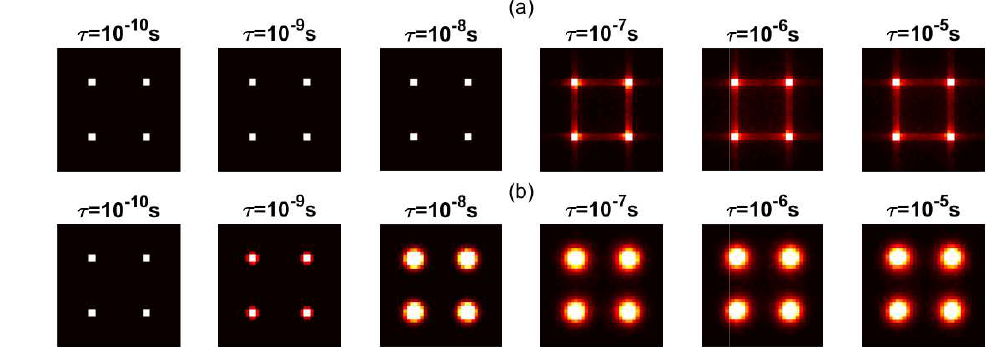
Figure 4. According to the time delay parameter, constellation histograms for ( a ) the real ELM with 10 hidden neurons and ( b ) the complex ELM with two hidden neurons.